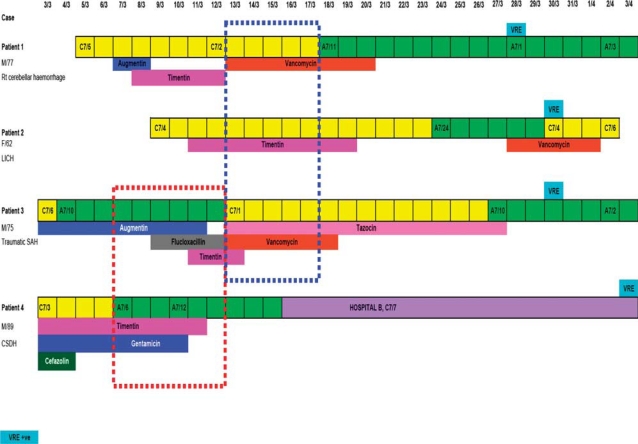
In-patient relationships and movements of the four patients with vancomycin-resistant Enterococcus faecium (VRE) in the neurosurgical unit of hospital A (unless specified) and details of their antimicrobial utilization. Solid blocks in yellow (C7) and green (A7)=days in which the patients stayed in the respective wards and beds in hospital A. Solid blocks in purple=days in which the patient stayed in hospital B. Dotted block in blue=days in which patients 1, 2, and 3 were staying in the same ward. Dotted block in red=days in which patients 3 and 4 were staying in the same ward.